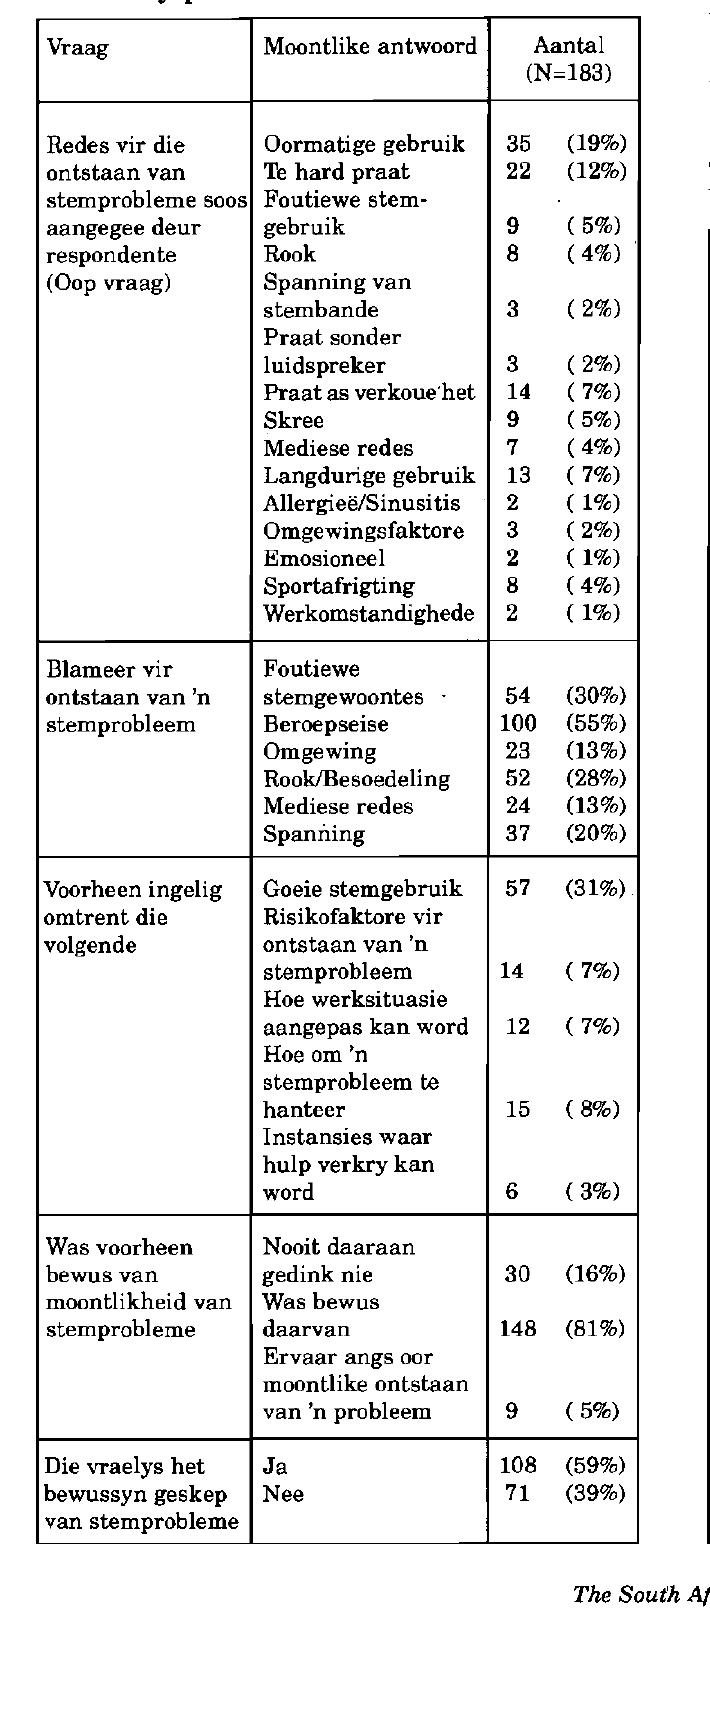
TABEL 2: Kennis van stemprobleme by die persone in onderwysprofessies